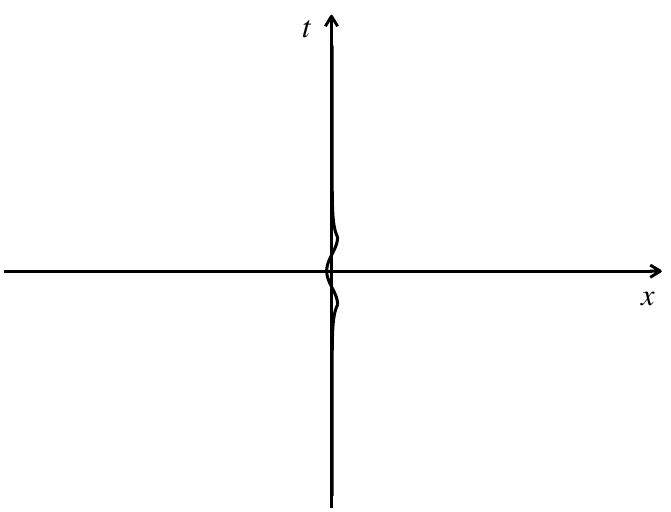
Figure 1. A schematic of the mirror’s worldline in ( 1 + 1 ) -dimensional spacetime, where the mirror approaches a static state at x = 0 when t → ± ∞